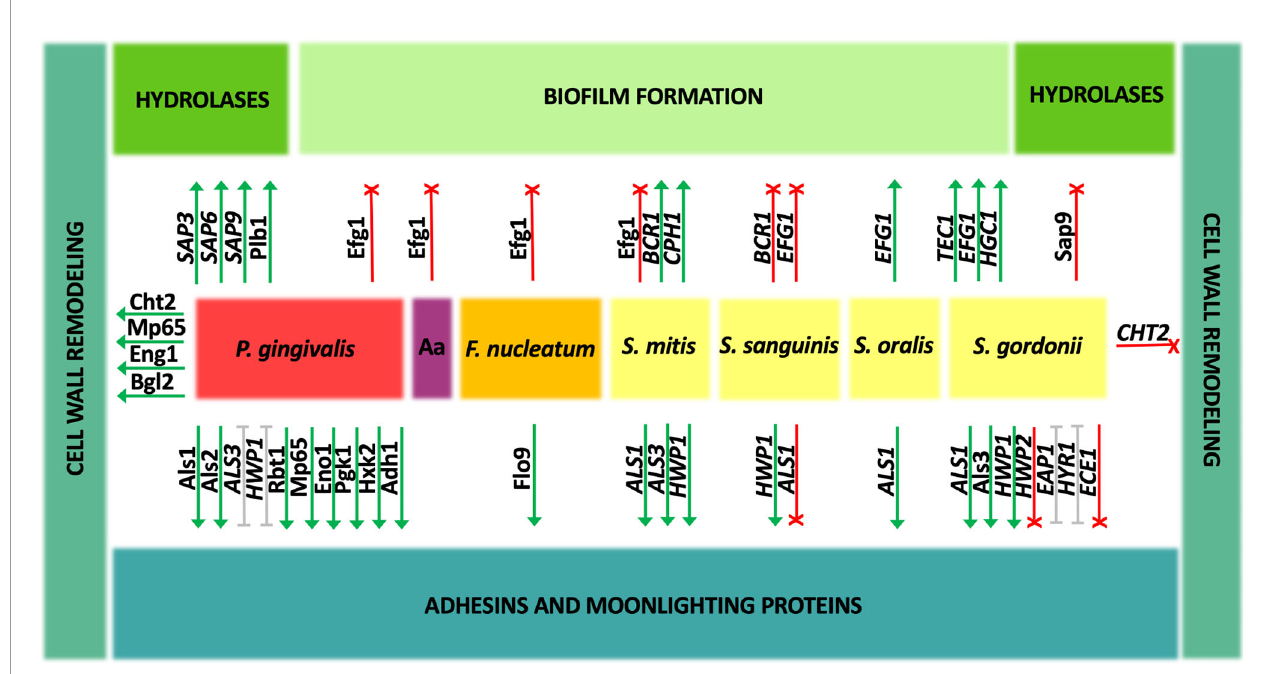
FIGURE 2 | Change in the gene expression and amounts of Candida albicans proteins during coexistence with oral bacteria. Interspecies interactions may show either an enhancement (green) or inhibitory (red) effect on individual C. albicans virulence factors. For some aspects (gray), the described effect is ambiguous and strictly depends on the experimental conditions. Aa, A. actinomycetemcomitans